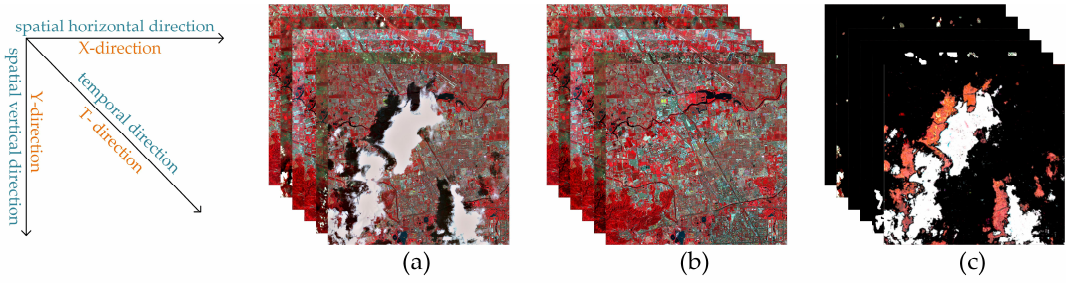
Figure 2. The images used to draw histograms ( a ) original cloud-contaminated images; ( b ) clean element; ( c ) cloud/shadow element.